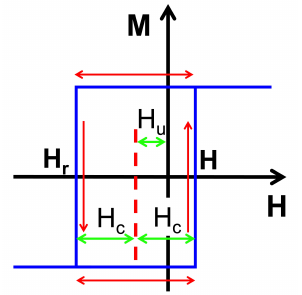
Figure 1. Scheme of mathematical hysteron corresponding to a bistable amorphous microwire. The green arrows denote the value of the coercive field H c and the bias field H u . The red arrows correspond to the magnetization